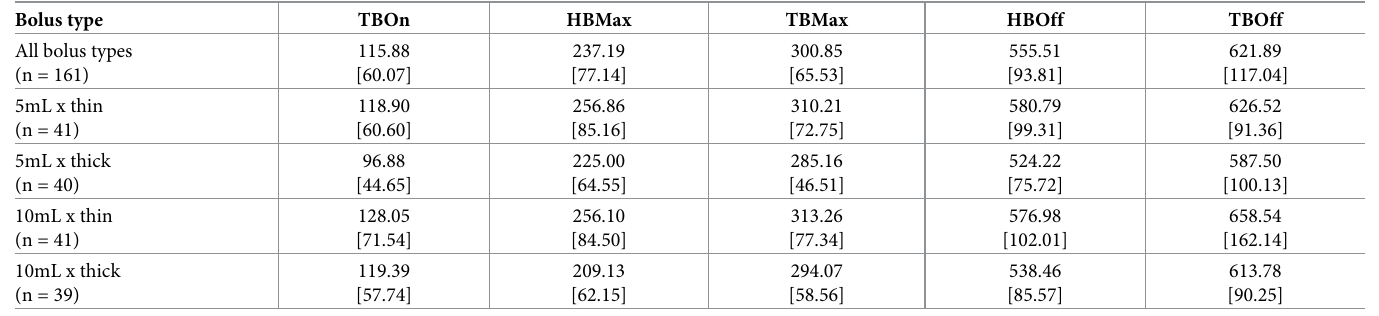
Table 2. Mean time difference (in ms) between the onset of hyoid bone excursion ( HBOn ) and different events. Bolus